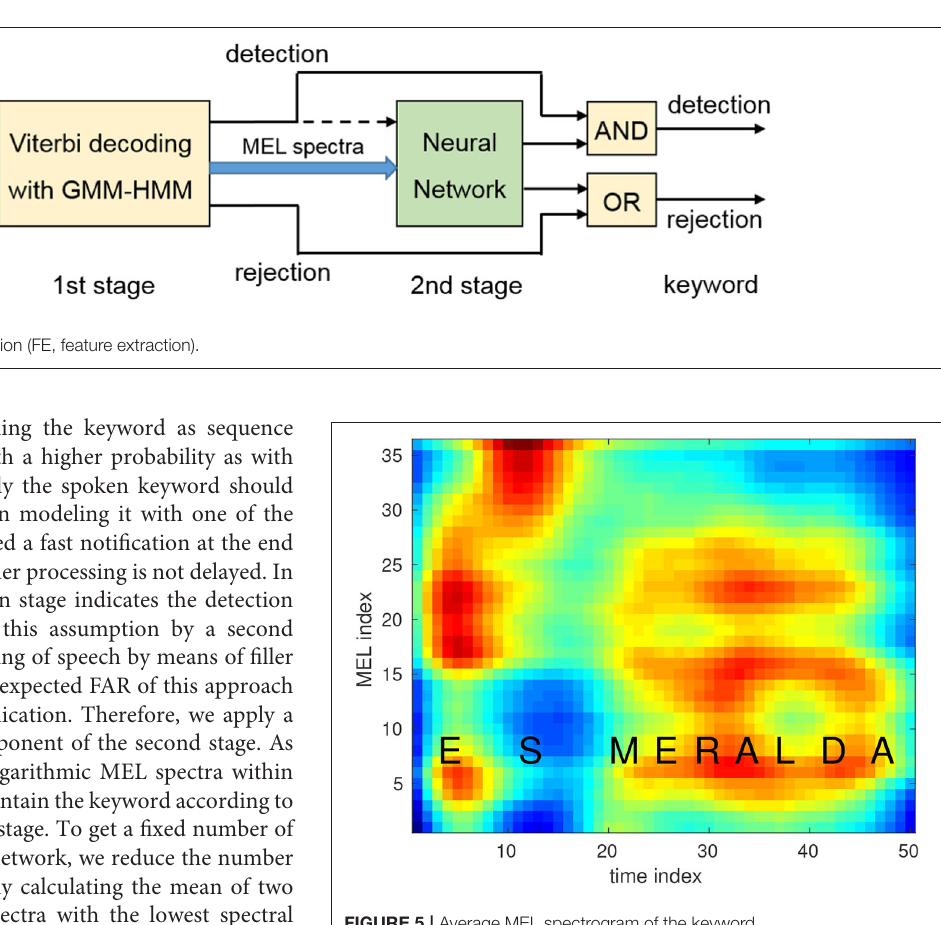
FIGURE 5 | Average MEL spectrogram of the